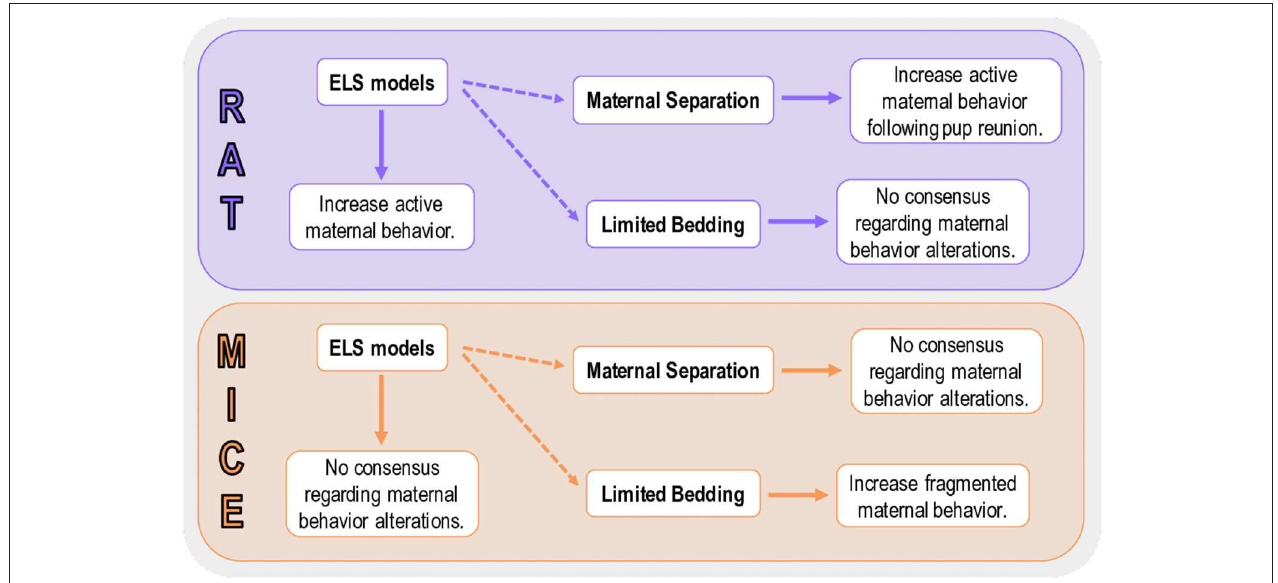
FIGURE 9 | Summary of the main findings for rat and mice studies. Active maternal behavior compromises behaviors that are actively performed by the dam and promote a profound impact on pup development (e.g., licking/grooming and arched-back nursing). Fragmented maternal behavior is performed when the dam exits the nest several times, but the overall amount of maternal care is not necessarily altered.